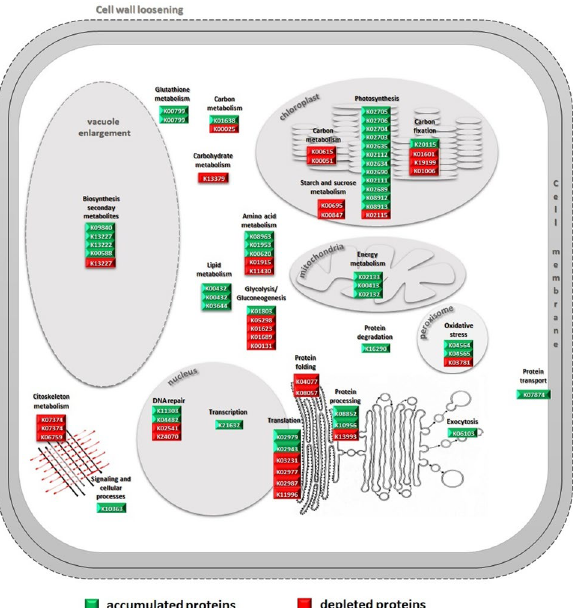
Figure 6. Schematic diagram of differentially expressed proteins belonging to metabolic pathways/cellular processes leading to the acclimation/tolerance of Cymodocea nodosa in volcanic vents. The acclimation strategy combines the reduction of carbon fixation, gluconeogenesis, carbohydrate metabolism and protein synthesis with increasing photophosphorylation, cell respiration and aminoacid metabolism to maintain the high energy demand for leaf expansion and elongation of the mesophyll cell; the cell expansion is accomplished by the cell wall loosening, the vacuole enlargement and the cytoskeleton remodeling. Proteins belonging the oxidative stress response pathway, the Gluthatione metabolism and the biosynthesis of secondary metabolites were also accumulated, suggesting that potential external stress factor other than CO 2 are at play at the Vulcano submarine vents. Proteins and related KEGG codes, reported also in Table 1, are developed by Kanehisa Laboratories 32